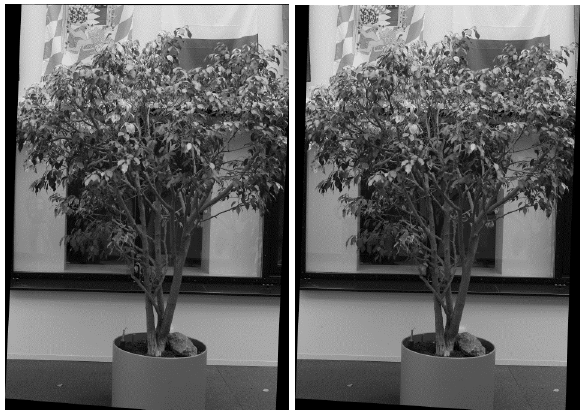
Figure 3. The epipolar image pair for dense matching